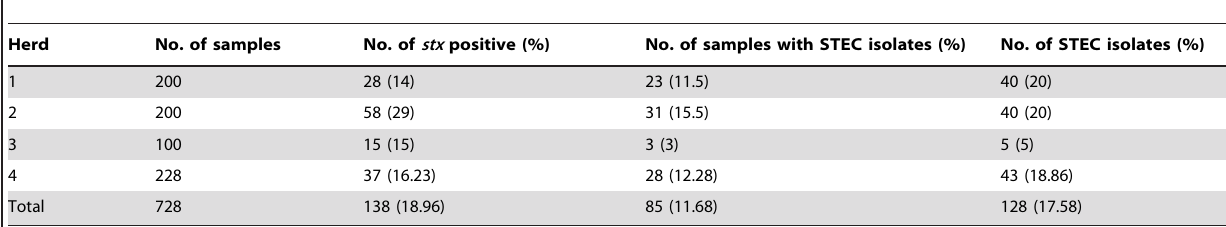
Table 2. Prevalence of Shiga toxin-producing Escherichia coli in